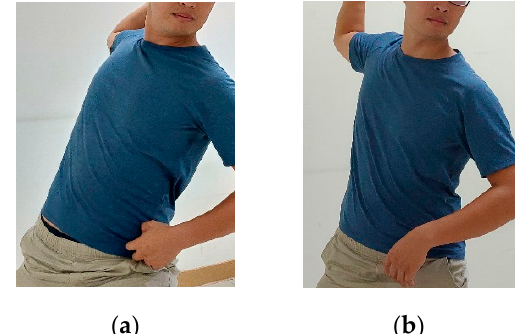
Figure 4. The contract of the torso rotation between two groups. ( a ) Normal group with larger torso rotation ( b ) GIRD group with less torso rotation.